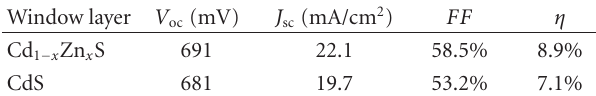
Figure 6: Transmittance curves of Cd 1 − x Zn x S thin films prepared at di ff erent pH values. Table 2: Parameters for CdTe thin film solar